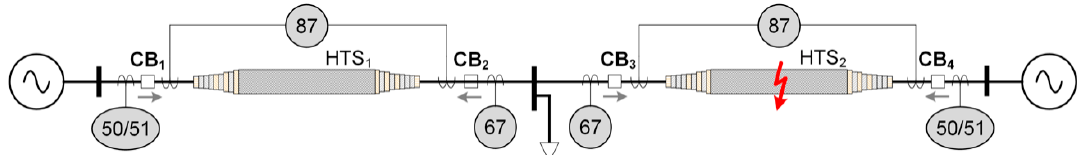
Figure 10. Relay trip signals in case DCRs operate normally: ( a ) relays in HTS 1 ; ( b ) relays in HTS 2 . Figure 11. Operation of circuit breakers in case DCRs operate normally. The three-phase transient currents through two HTS cables are shown in Figure 12. Initially, two HTS cables conduct an RMS current of 2 kA to supply power for the local load. The fault at 0.5 s causes a rapid increase of HTS 2 current from 2 kA to 24.5 kA. The current through the HTS 2 is decreased to zero after 0.592 s due to the opening of CB 3 and CB 4 . Meanwhile, the current in HTS 2 increases after clearing the fault. Figure 13 shows the power flow into two HTS cables. Initially, two cables conduct the same amount of power. Three-phase-to-ground fault occurs at 0.5 s, resulting in a rapid increase of powers through both HTS cables from 60 MW to 510 MW. After clearing the fault at 0.592 s, the power in HTS 2 is reduced to zero while the power in HTS 1 is doubly increased compared to the initial condition.